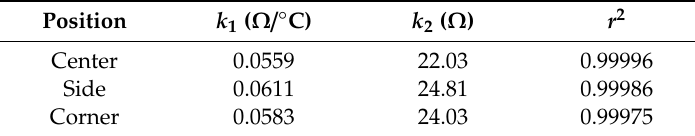
Figure 5. Calibration curve of the RTDs. The markers show measurement points, the dashed lines corresponding linear fits. Table 1. Fitting parameters of calibration curves.